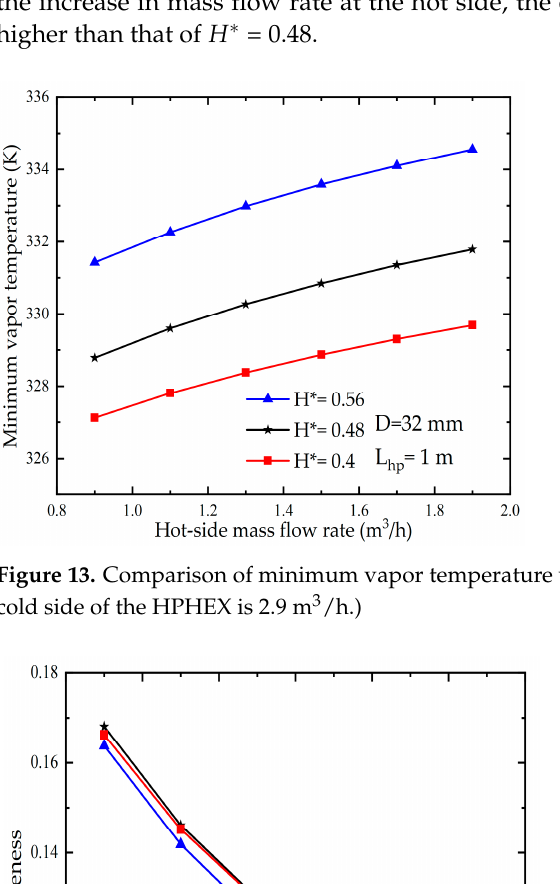
* H . (The mass flow rate at cold side of the